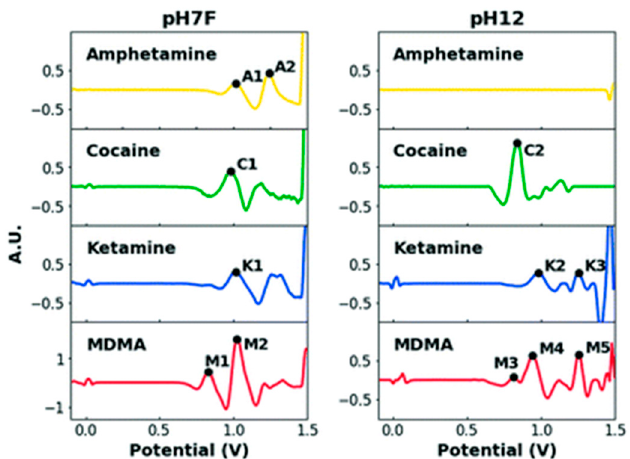
Figure 3. Pre-processed SWV electrochemical profiles of the four selected illicit drugs in pH 7F (a pH 7 PBS buffer containing some formaldehyde, left ) and pH12 ( right ), with relevant peaks labeled [47]. Reused from the Royal Society of Chemistry under a Creative Commons Attribution-NonCommercial 3.0 Unported Licence.